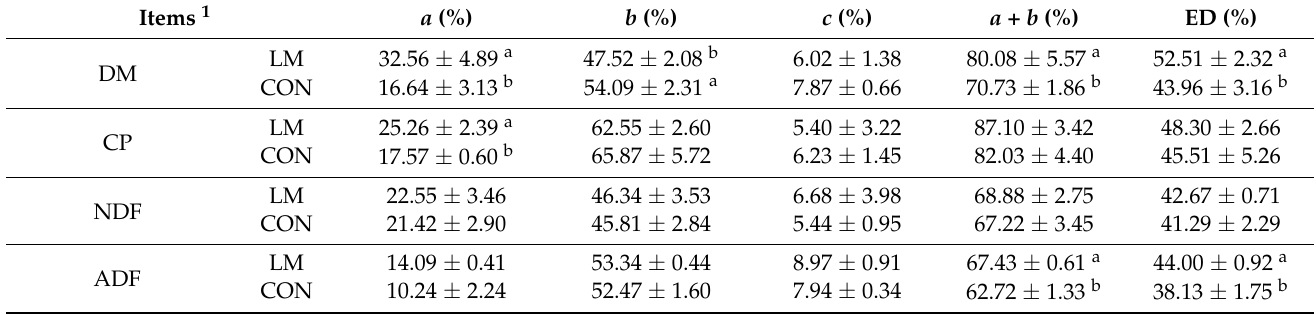
Table 5. Ruminal degradation kinetics of DM, CP, NDF, and ADF of paper mulberry